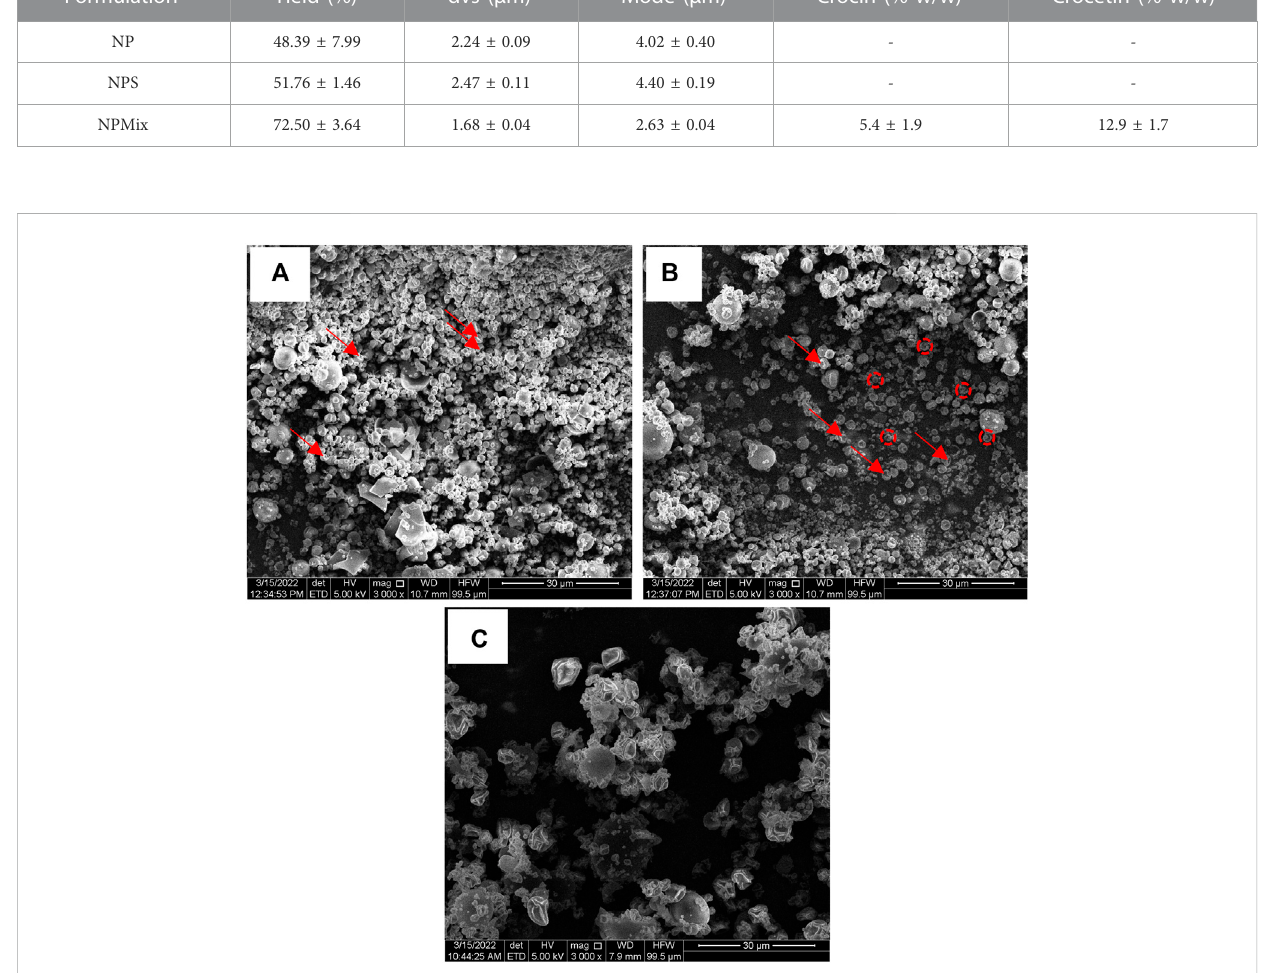
FIGURE 4 SEM images of NP (A) , NPS (B) and NPMix (C) formulations. 3000 × magni fi cation. Red arrows point out some invaginations, while red circles detail particle